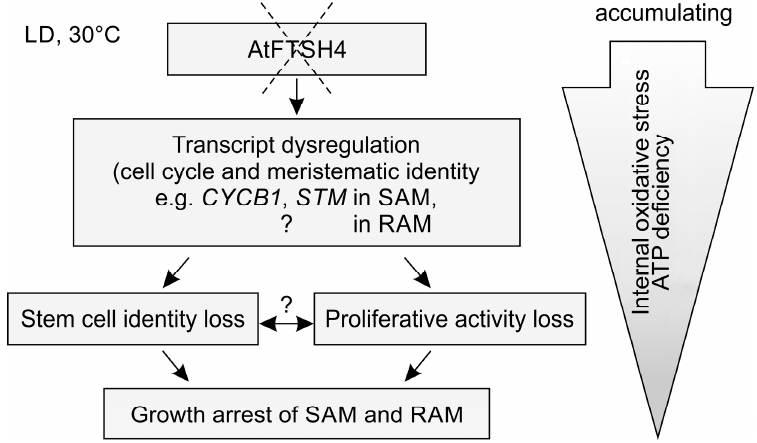
Figure 4. Developmental impairment of meristem proliferation and stem cell identity in plants lacking the mitochondrial protease AtFTSH4. In stress-inducing conditions of mildly elevated temperature of 30 °C, absence of AtFTSH4 in mitochondria (shown as dashed X) results in progressive accumulation of internal oxidative stress (ROS, carbonylated proteins, AOX transcripts) with time/plant age and ATP deficiency [22,24,25]. Stem cells within the meristems lose their meristematic characteristics and ability to proliferate. In the shoot apical meristem (SAM), this relates to the transcript dysregulation of cell cycle-related genes and those sustaining meristematic identity. Ultimately, growth of the SAM and RAM in the ftsh4-1 mutant plants is precociously arrested. Question marks refer to probable, but not yet proven experimentally correlations.